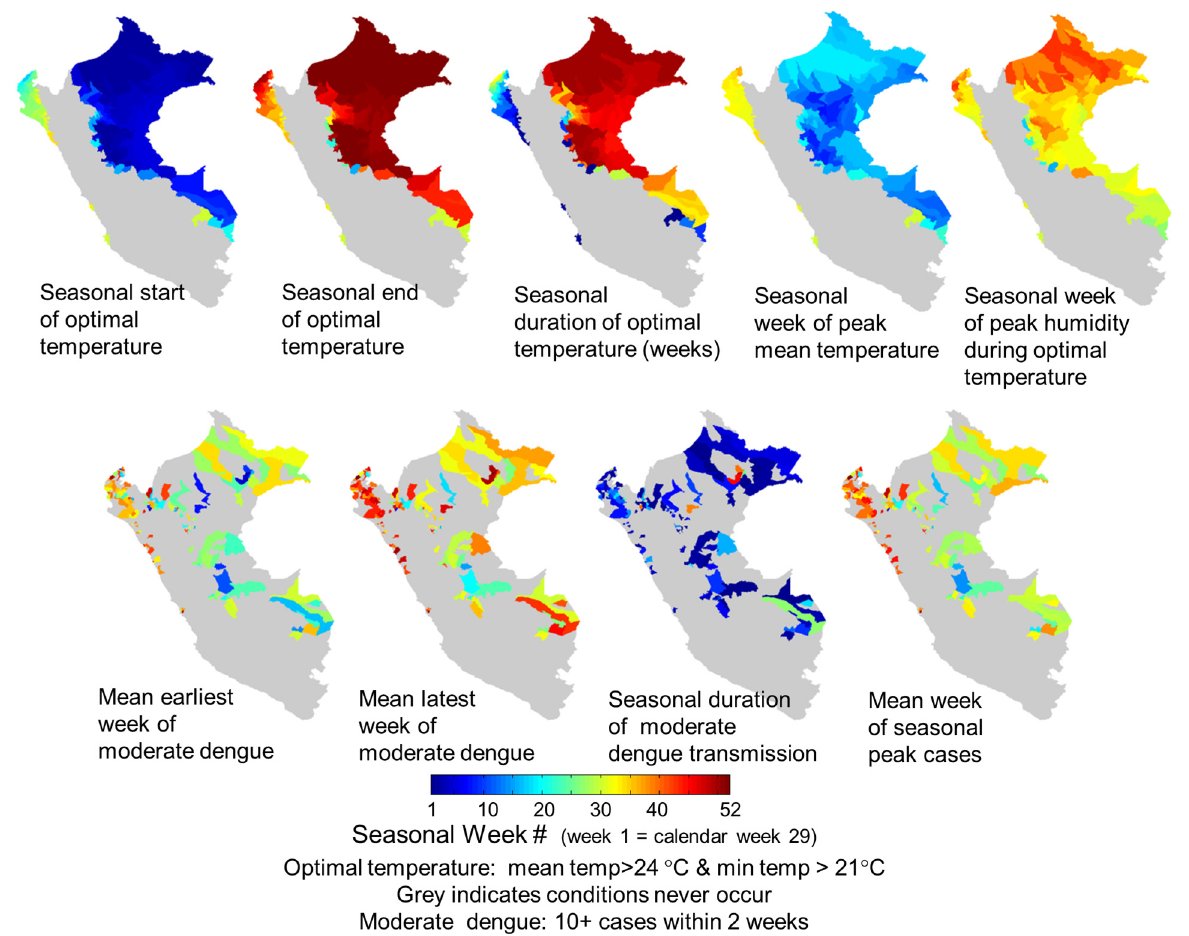
Fig 7. Annual timing of optimal weather conditions and dengue transmission in Peru, 2005 – 2012. Top row: The seasonal timing and duration of optimal temperature for transmission varies spatially and does not occur at all in south/central areas of low (and no) transmission. Top right: The seasonal timing of highest humidity during optimal temperature affects the timing and magnitude of larger seasonal cycles. Bottom row: The seasonal timing and duration of moderate levels of transmission (10+ cases per 2 weeks per district) and seasonal peak transmission varies spatially. The duration of moderate or greater transmission is longest in Maynas, Alto Amazonas, Ucayali, and Madre de Dios, which suggests these areas have a primary role in spreading transmission throughout the region, since in most areas of Peru, duration is short and peak occurs at very different times of the year. Seasonal peak transmission is most closely aligned with peak humidity when temperature is optimal and not well aligned with seasonal peak